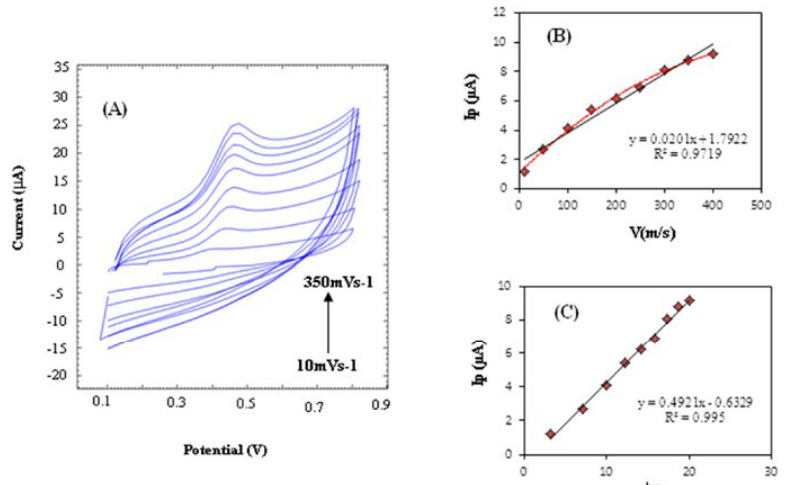
Fig. 6 . Cyclic voltammograms for the oxidation of insulin at several scan rates (1) 10 (2) 50 (3) 100 (4) 150 (5) 200 (6) 250 (7) 300 (8) 350 mVs −1 (B) Changes in the intensity of cranial oxidation peak of insulin in terms of scan rate (C) square root of scan rate versus oxidation peak current